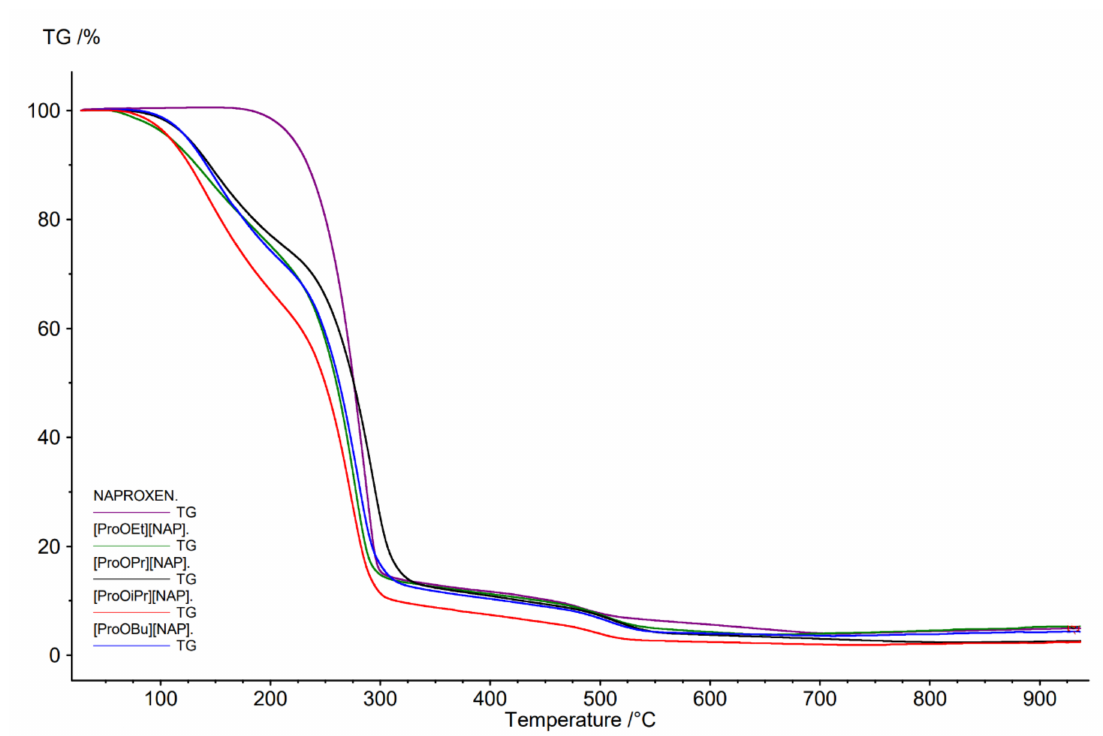
Figure 6. The TG curves of naproxen (purple), L-proline alkyl ester naproxenates-[ProOEt][NAP] (green), [ProOPr][NAP] (black), [ProOiPr][NAP] (red), and [ProOBu][NAP] (blue).